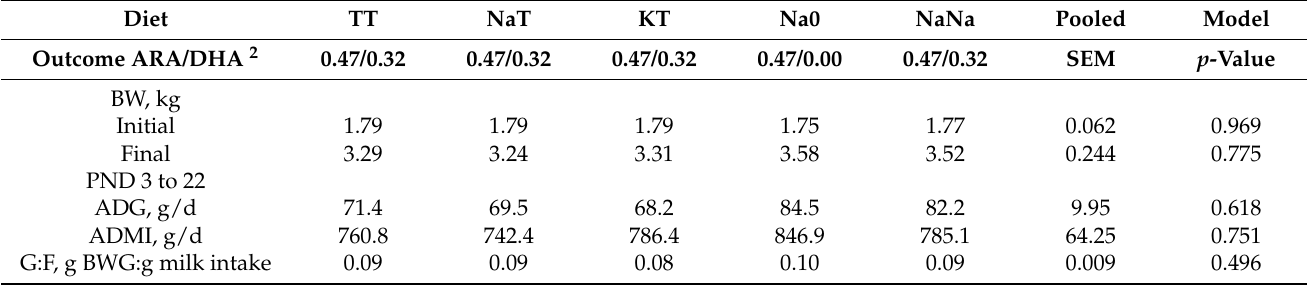
Table 2. Growth performance of pigs receiving experimental milk replacers with different sources of ARA 1.